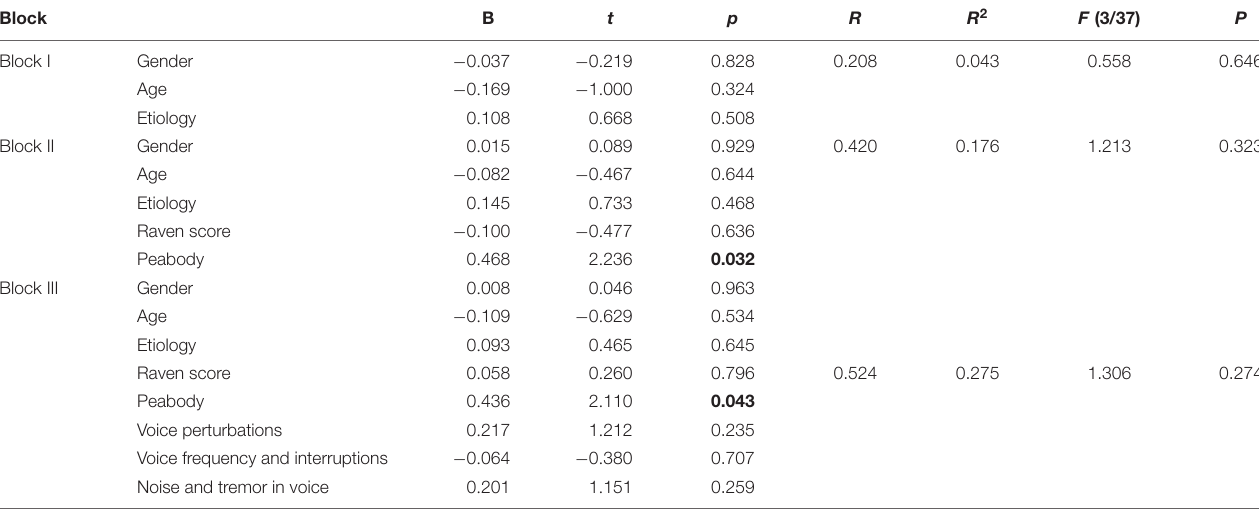
TABLE 4 | Results of hierarchical regression analysis for predicting paralinguistic comprehension of emotions.